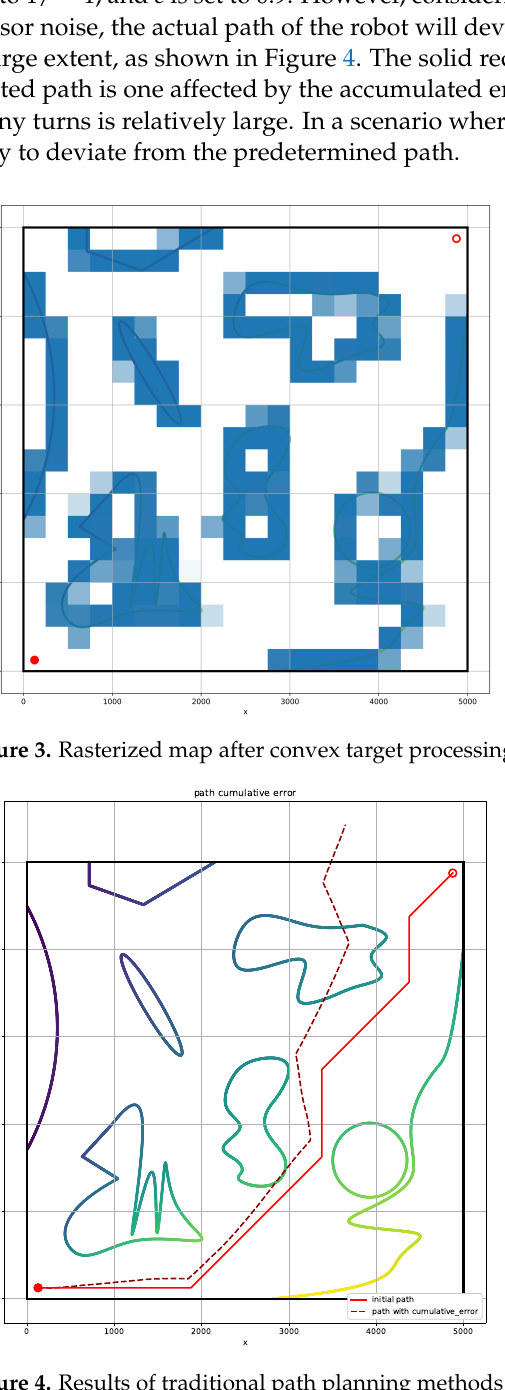
Figure 4. Results of traditional path planning methods and paths with